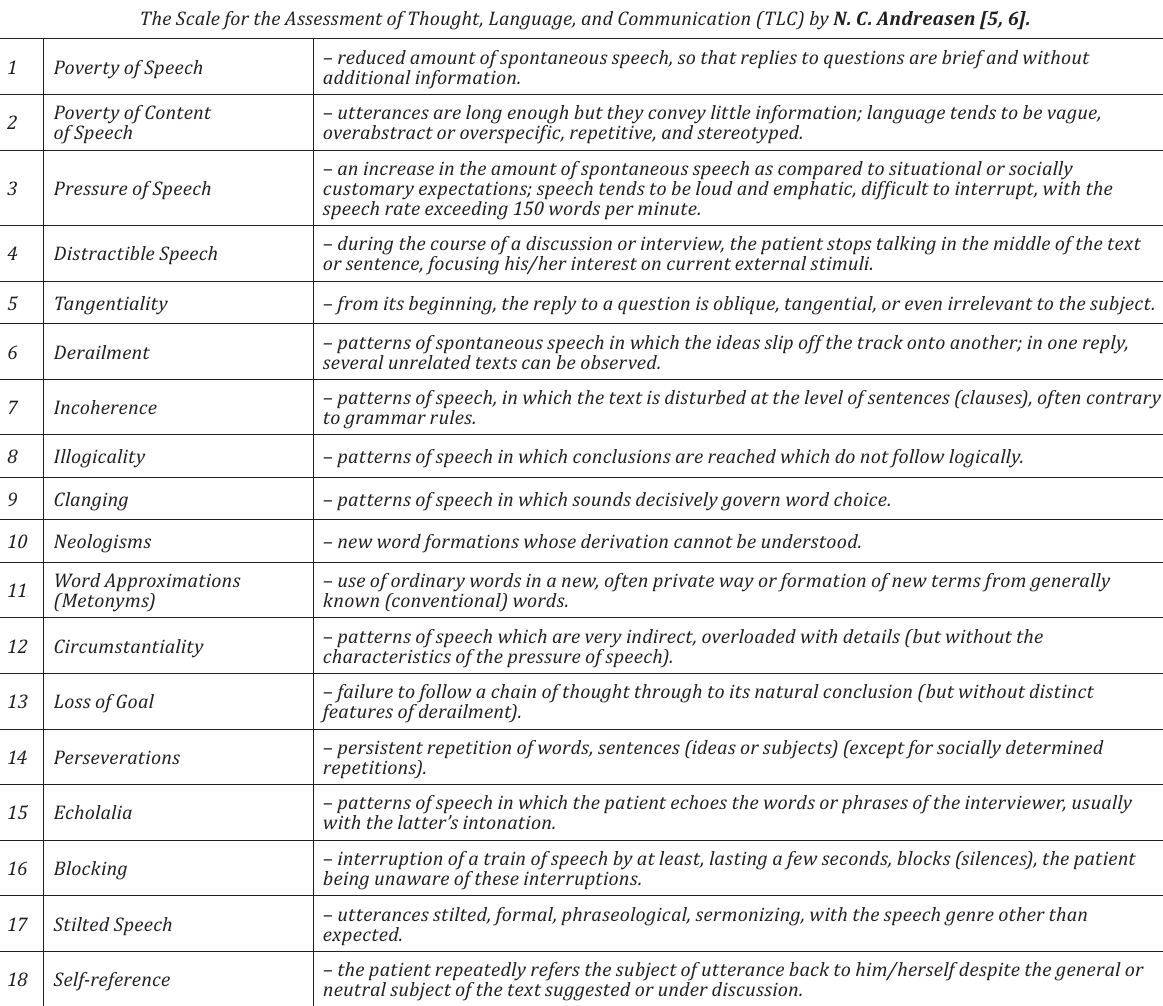
Table 1. Categories of utterance assessment in the TLC